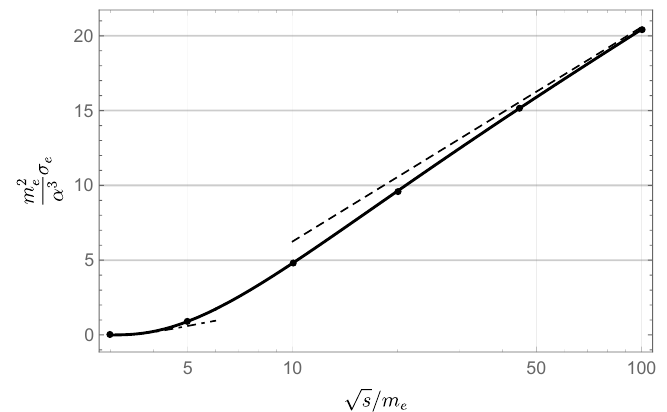
(cid:0) 28ln s (cid:1) − 218 only, while eq. (4.11), taking into account 9 27